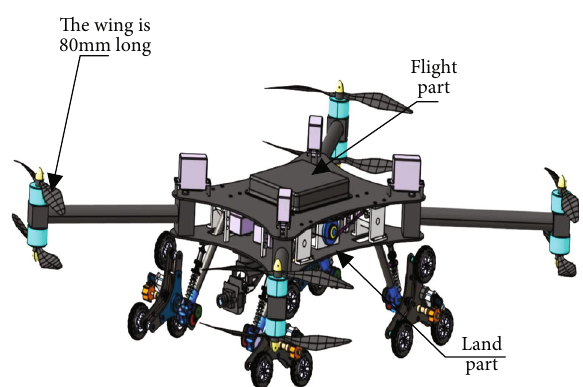
Figure 1: Schematic structure of air-ground amphibious reconnaissance